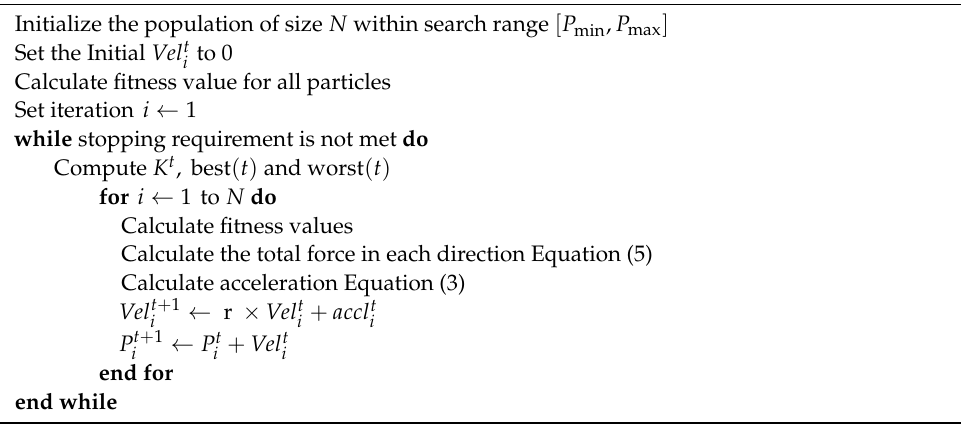
Algorithm 1 Artificial Electric Field Algorithm